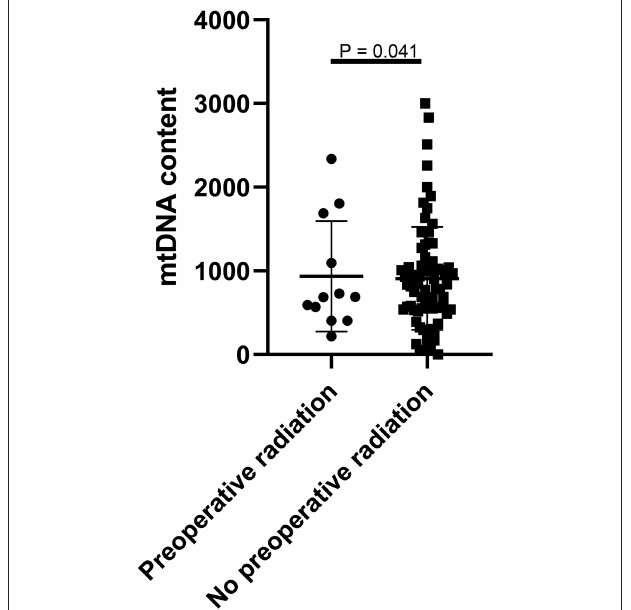
FIGURE 1 | mtDNA content was significantly lower in patients with preoperative radiation therapy.